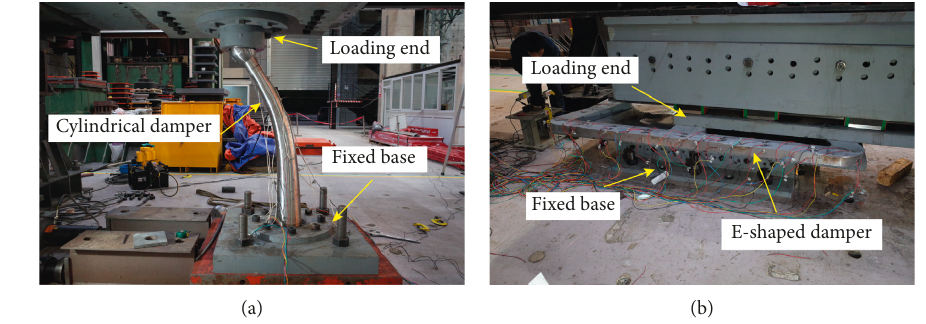
Figure 17: Photographs of the damper test. (a) Cylindrical. (b)